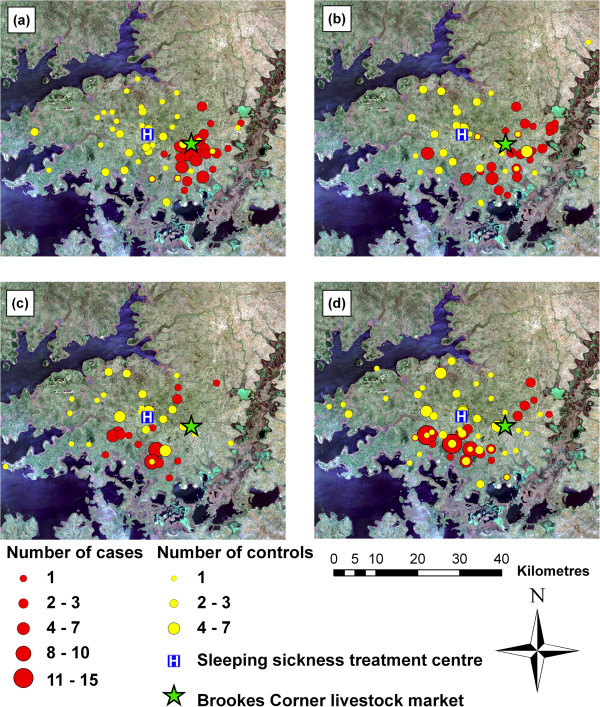
True colour Landsat ETM+ composite of study area. True colour Landsat ETM+ composite of study area showing distribution of cases and controls (as counts for each location) in the first (a), second (b), third (c) and fourth (d) annual periods, with HAT treatment centre and Brookes Corner livestock market.